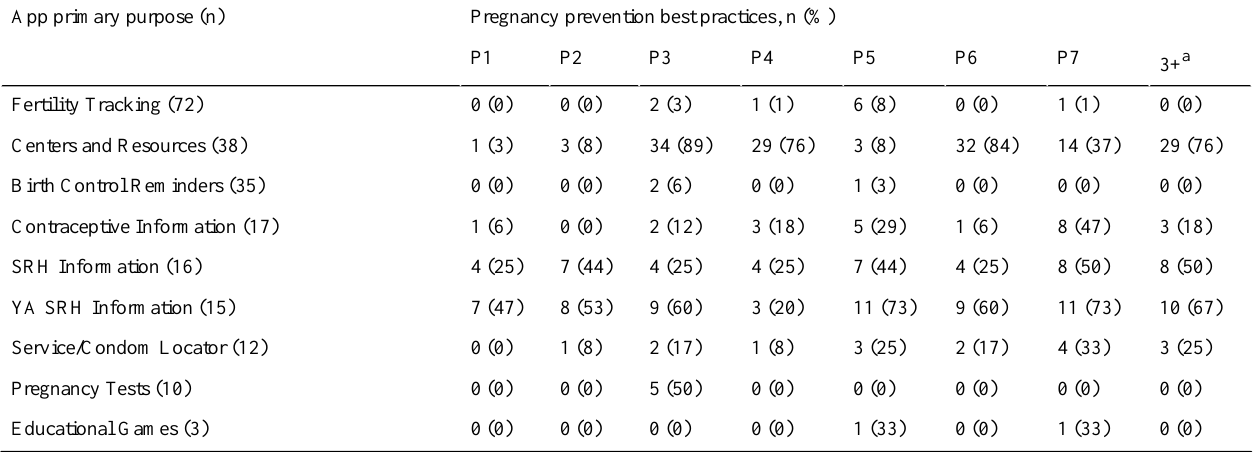
Table 1. Number and percentage of pregnancy prevention best practices in apps by app purpose.